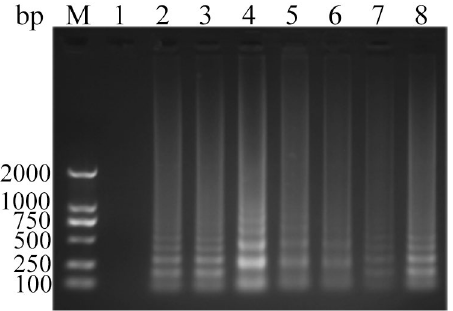
Figure 5. Analysis of ALV-J CPA at different concentration of dNTPs by agarose gel electrophoresis. Lane M, DNA marker; 1, 0 mmol L −1 ; 2, 0.2 mmol L −1 ; 3, 0.4 mmol L −1 ; 4, 0.6 mmol L −1 ; 5, 0.8 mmol L −1 ; 6, 1.0 mmol L −1 ; 7, 1.2 mmol L −1 ; 8, 1.4 mmol L −1 . The full-length gel is presented in Supplementary Figure S21.